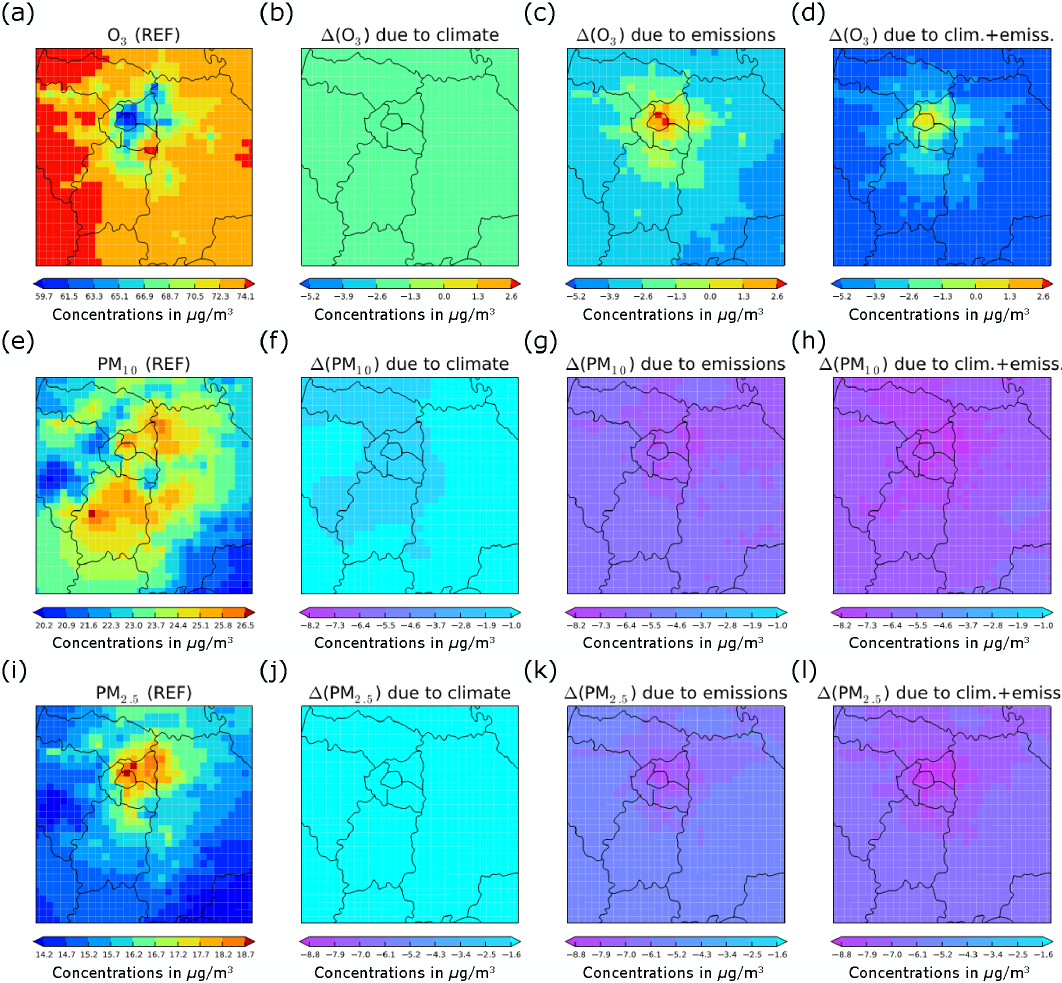
Figure 4. April–August mean ozone, annual mean PM 10 and annual mean PM 2 . 5 concentration maps (µgm − 3 ) for IdF, expressed as absolute values at present-time (a, e, i) and as deltas between present-time and 2050 due to climate change (b, f, j) , emissions changes (c, g, k) and the cumulative effect (d, h, l)